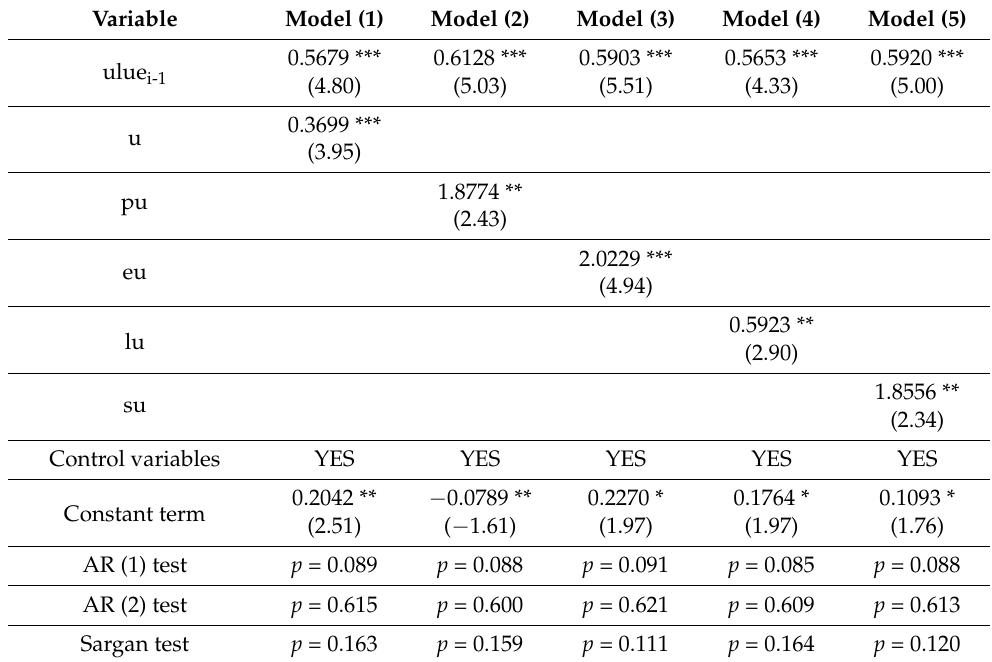
Table 8. Robustness test—A Control Variable